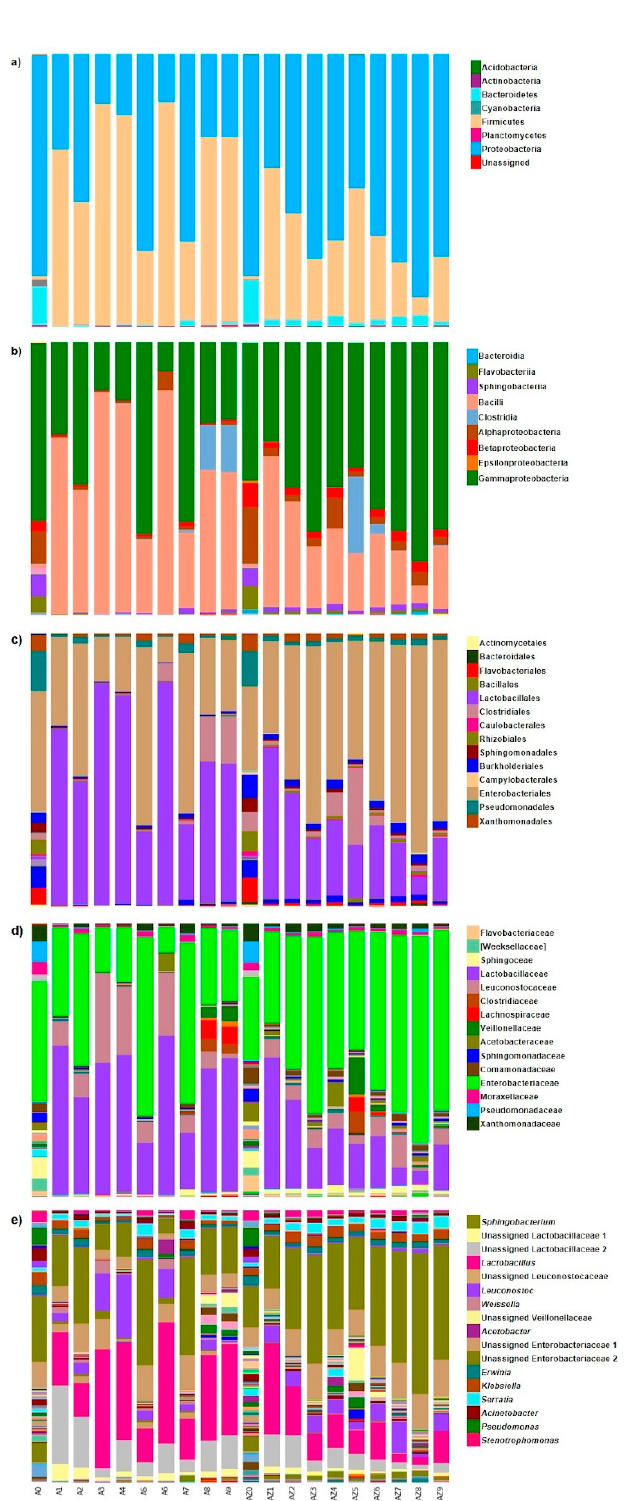
Figure 1. Relative abundance of dominant bacterial species of maize silage samples at the level of ( a ) phylum, ( b ) class, ( c ) order, ( d ) family, and ( e ) genus. Samples A0–A9 correspond to samples of Antilope silage, and AZ0-AZ9 to samples of Amarillo Zamorano silage, both in 10 sampling times.